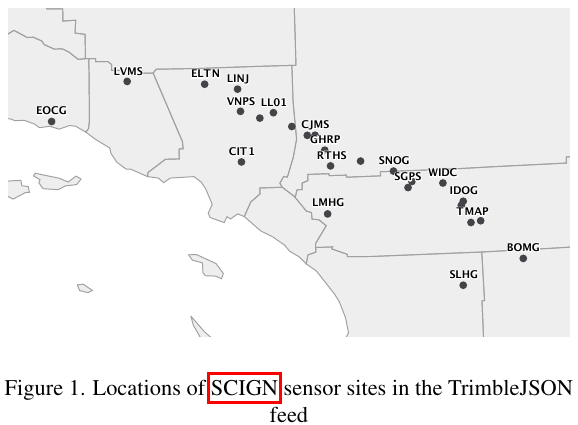
Figure 1. Locations of SCIGN sensor sites in the TrimbleJSON